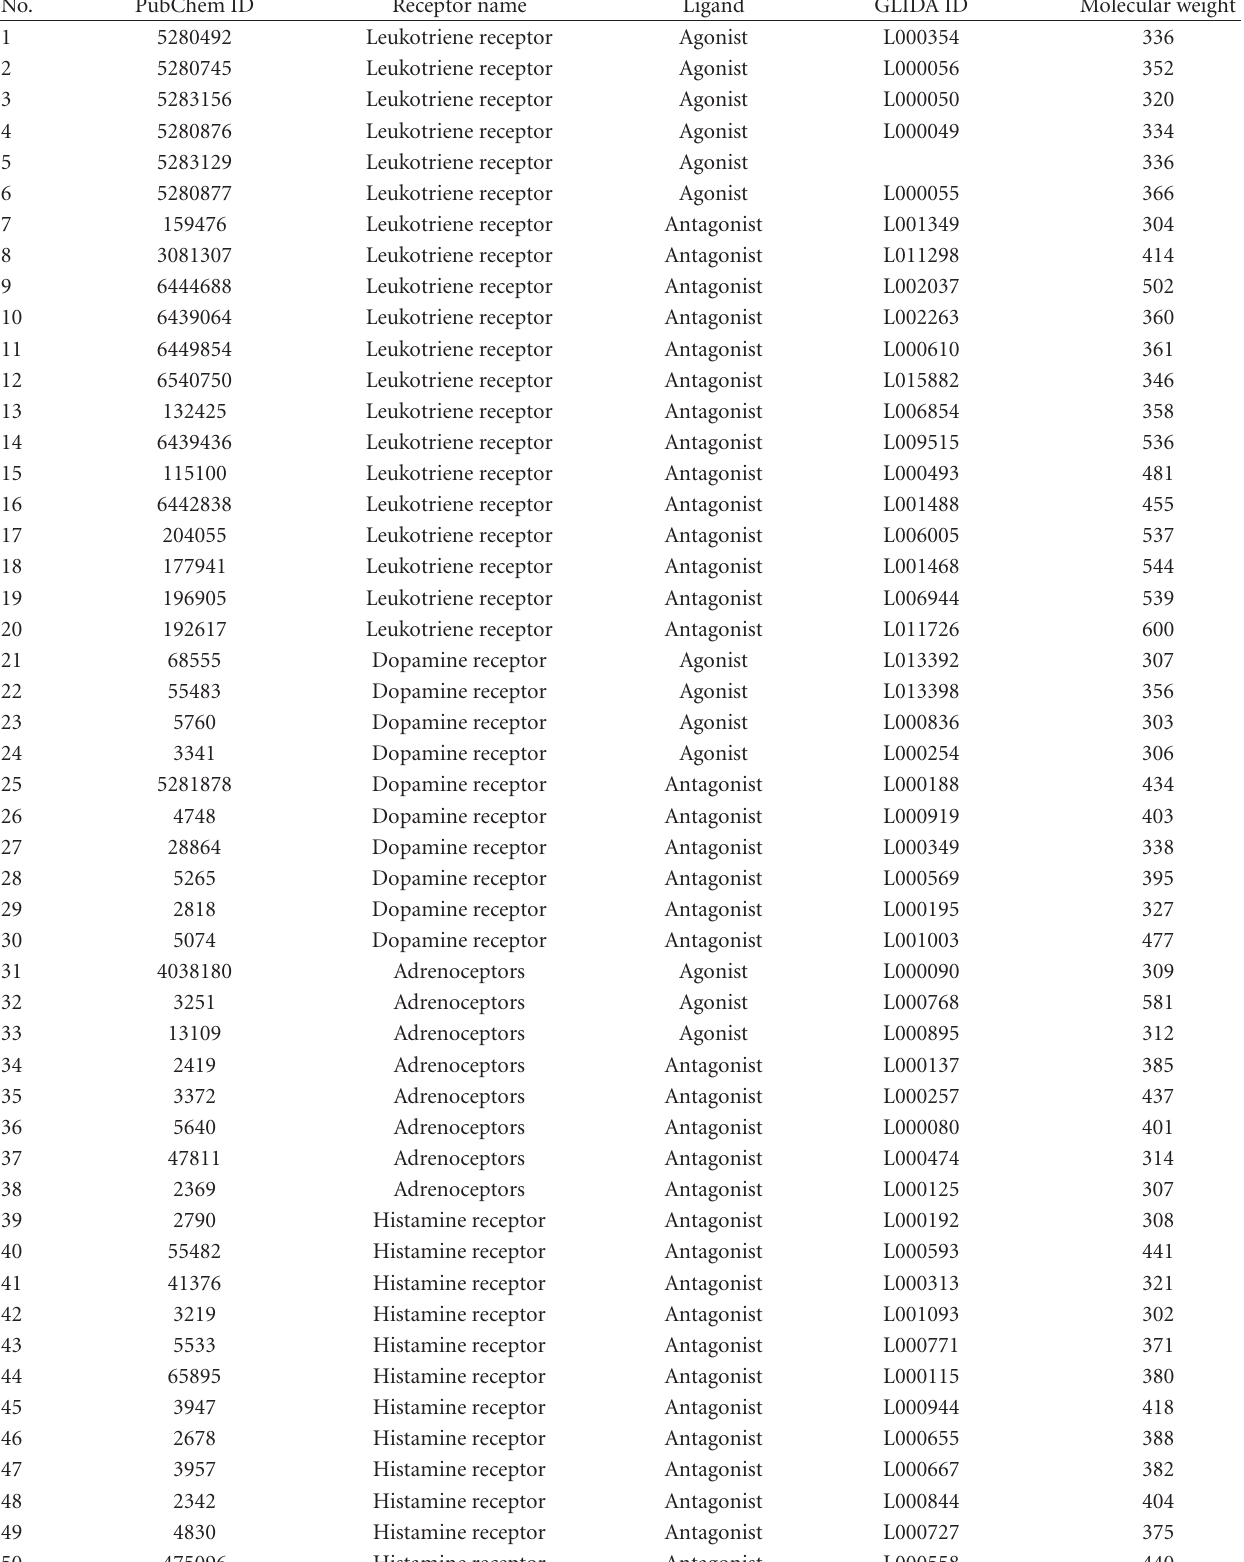
Table 1: Ligands used for